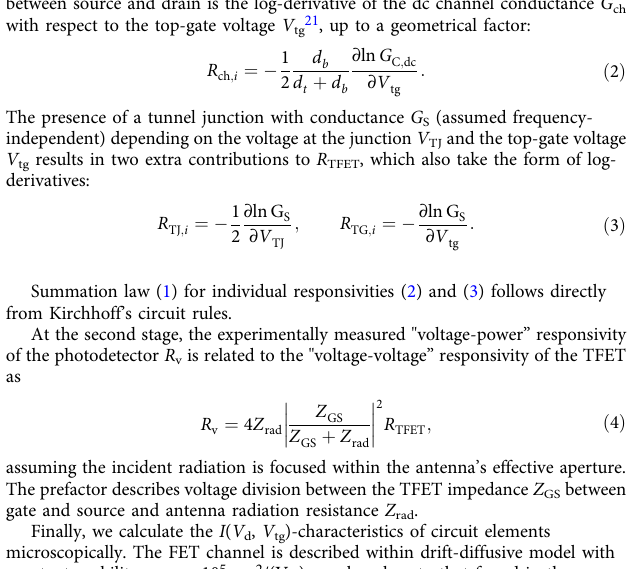
Fig. 5 Equivalent circuit of the BLG-TFET detector. Antenna is modelled as an equivalent voltage source V ant that generates ac current I THz (red arrows) fl owing into the source and escaping the FET channel through the gate capacitance. Recti fi cation occurs mainly at the tunnel barrier between source and channel (see band alignment pro fi le in the inset) with voltage- dependent conductance G S . The doping level and the band gap size is controlled via a simultaneous action of the top and bottom gate voltages, V V V tg and tg , respectively. The photovoltage, ph , is read out between the source and drain